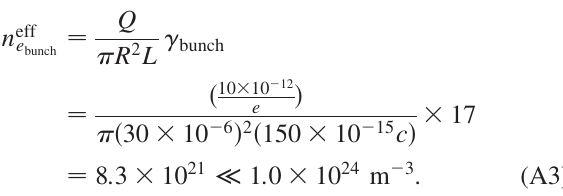
loading effects only causes a small decrease of the final energy ( < 1% ). There is however an increase in the energy spread and a decrease in the trapped charge (more electrons get radially expelled) due to the repulsive forces within the electron bunch.